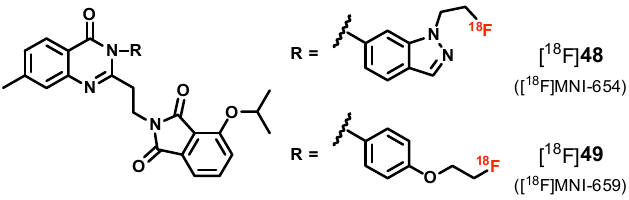
Figure 10. Molecular structures of 18 F-labeled PDE10A radioligands for PET.